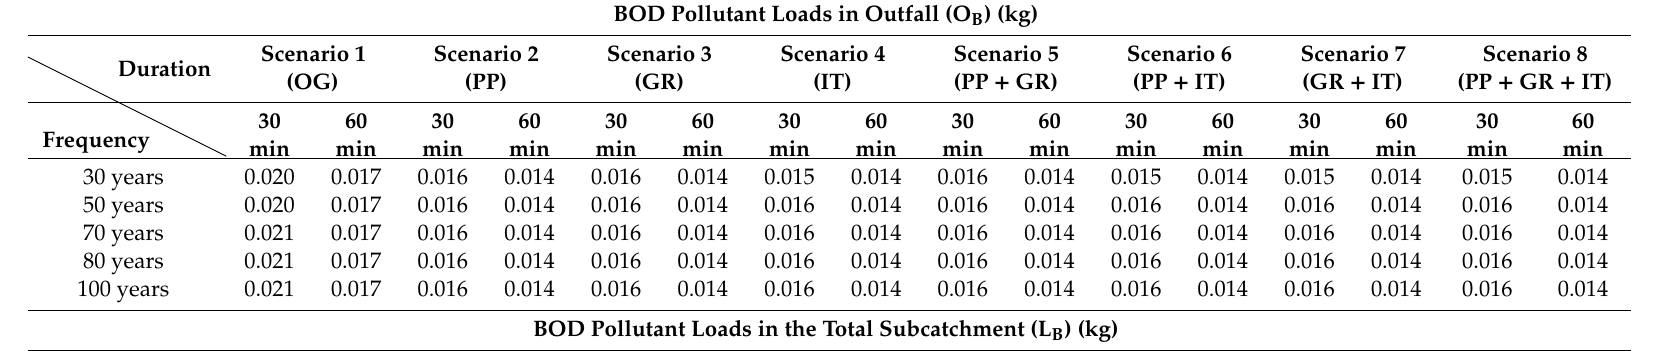
Table 8. BOD pollutant load reliability